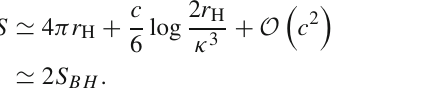
Inserting (3.19) to (3.16), we can obtain the entanglement entropy